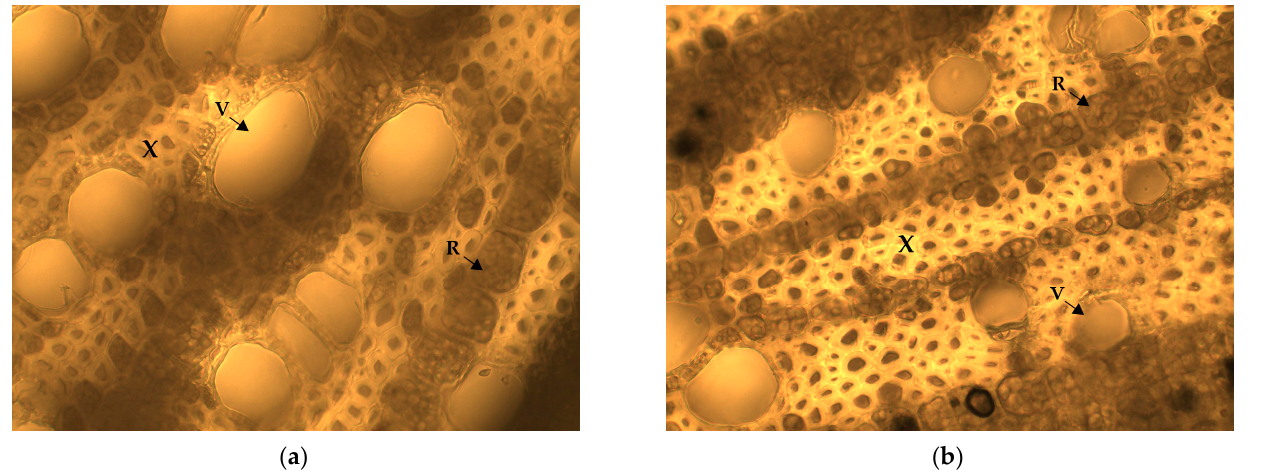
Figure 1. Light micrographs of root cross-sections of investigated contrasting cherry species ( a ) PC_02_03/2; ( b ) PF_02_16. V—vessel, R—ray, X—xylem. ( a ) PC_02_03/2; ( b ) PF_02_16. V—vessel, R—ray,